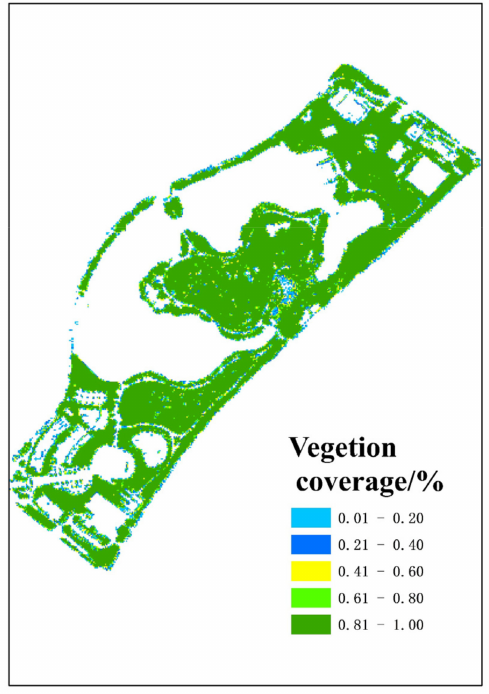
Figure 9. Vegetation coverage of the vegetated